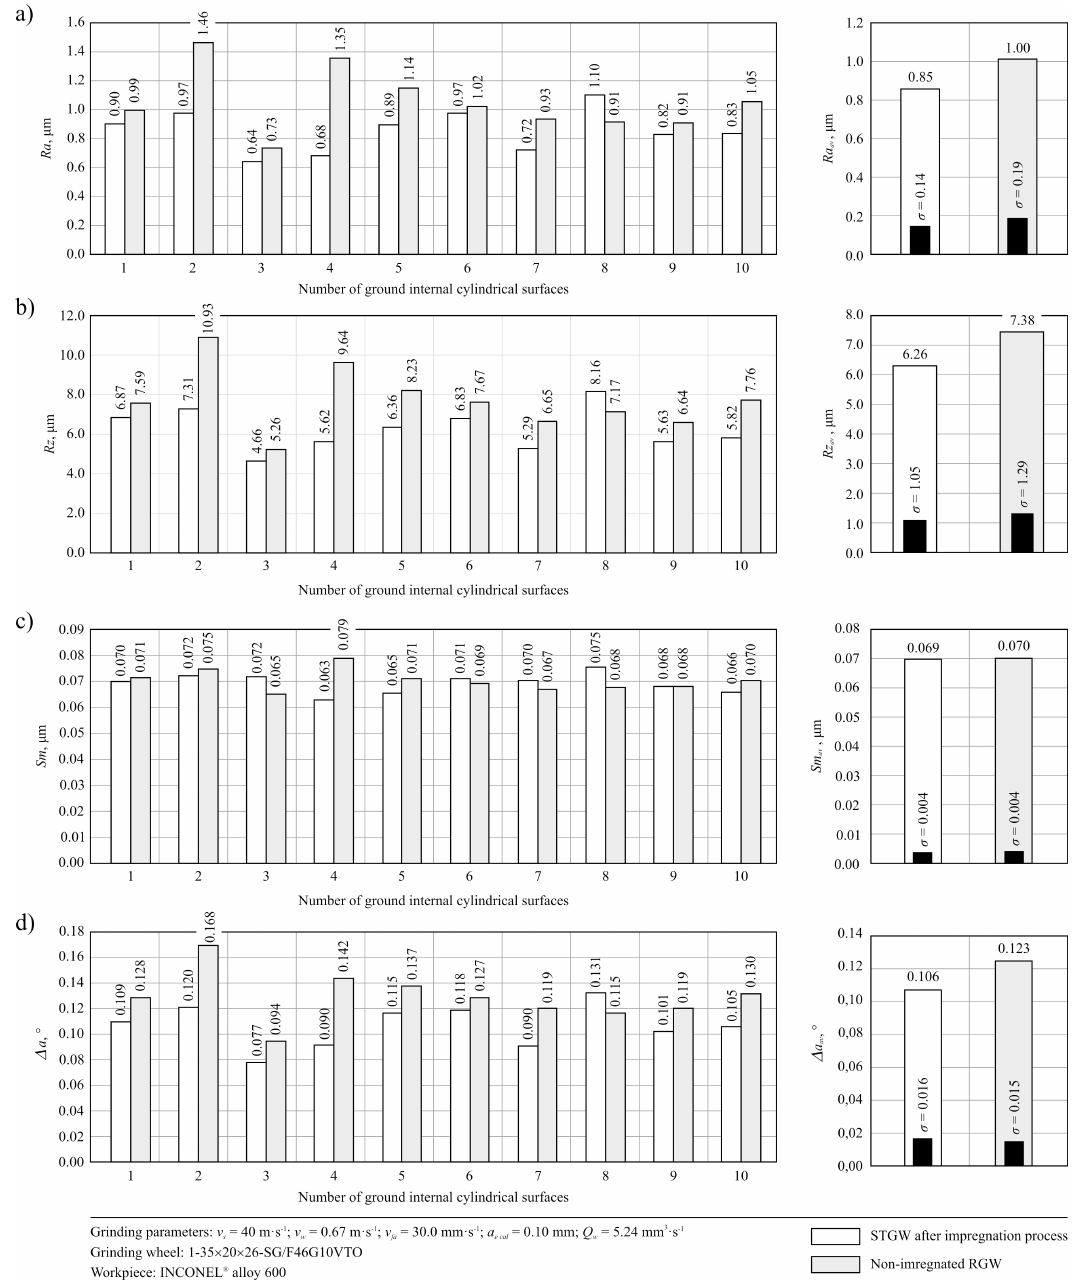
Figure 5. Bar charts presenting changes in values of selected set of parameters obtained during the measurements of ground surface microgeometry machined by STGW and RGW carried out using stylus profilometer Hommelwerke Hommel–Tester T8000: ( a ) Ra ; ( b ) Rz ; ( c ) Sm ; ( d ) Δ a .